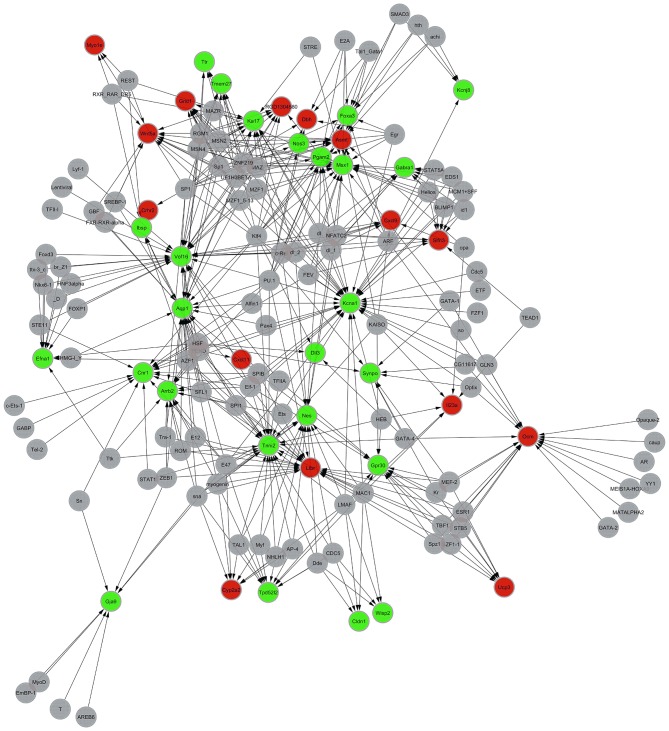
Diagram of the networks regulating the transcription of the differentially expressed genes in the model group compared with the XYS group. Red and green represent upregulated and downregulated genes, respectively, and gray represents TFs. The arrow indicates the direction in which the TF target (TFT) genes are regulated by transcription factors (TFs).